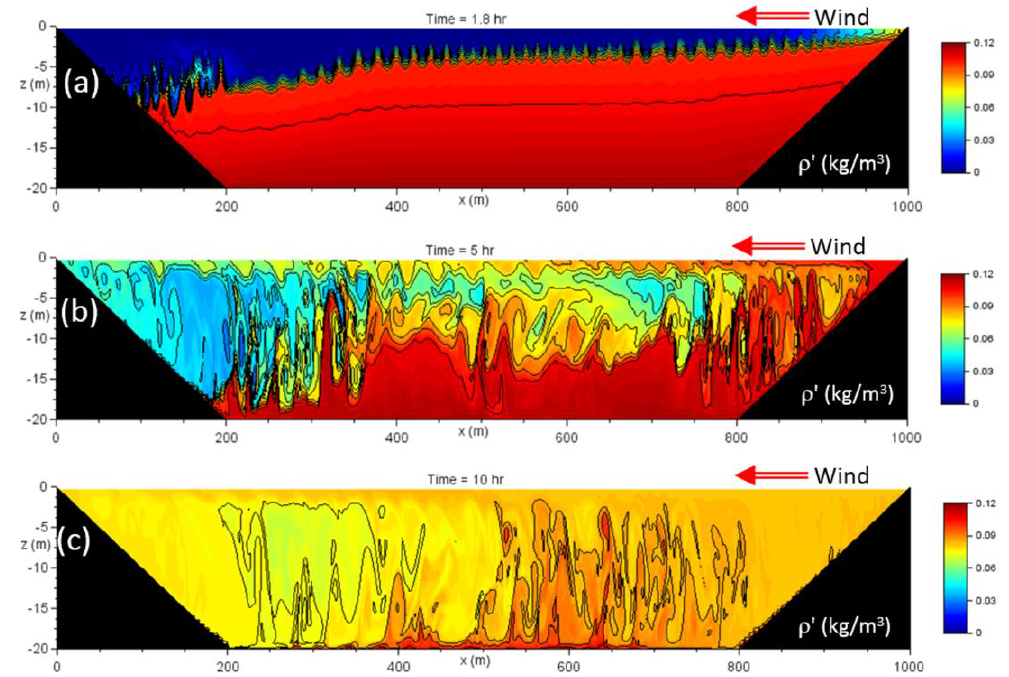
Figure 13. Scenario C with τ x = −0.1 Pa and Δ ρ = 0.1 kg/m 3 . Shown are density distributions after ( a ) 1.8 h; ( b ) 5 h; and ( c ) 10 h of simulation. Small arrows indicate the propagation direction of internal waves. See GIF Animation S4 for a simulation of this experiment.